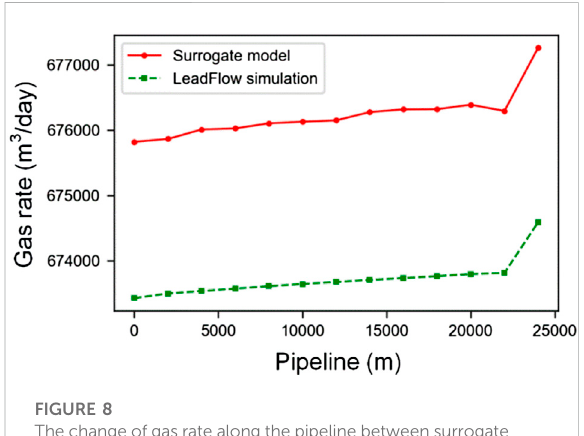
FIGURE 10 The water rate change along the pipeline between surrogate mode and LeadFlow